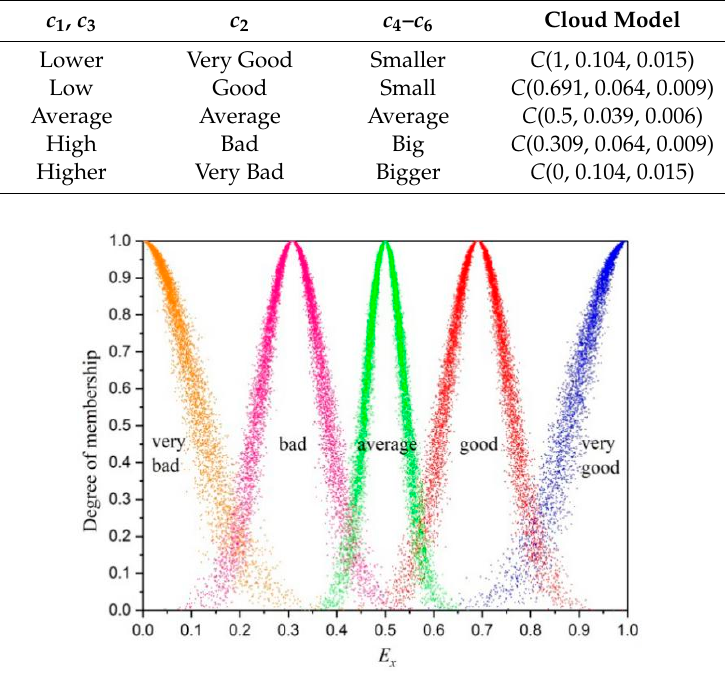
Figure 2. Normal cloud model image.